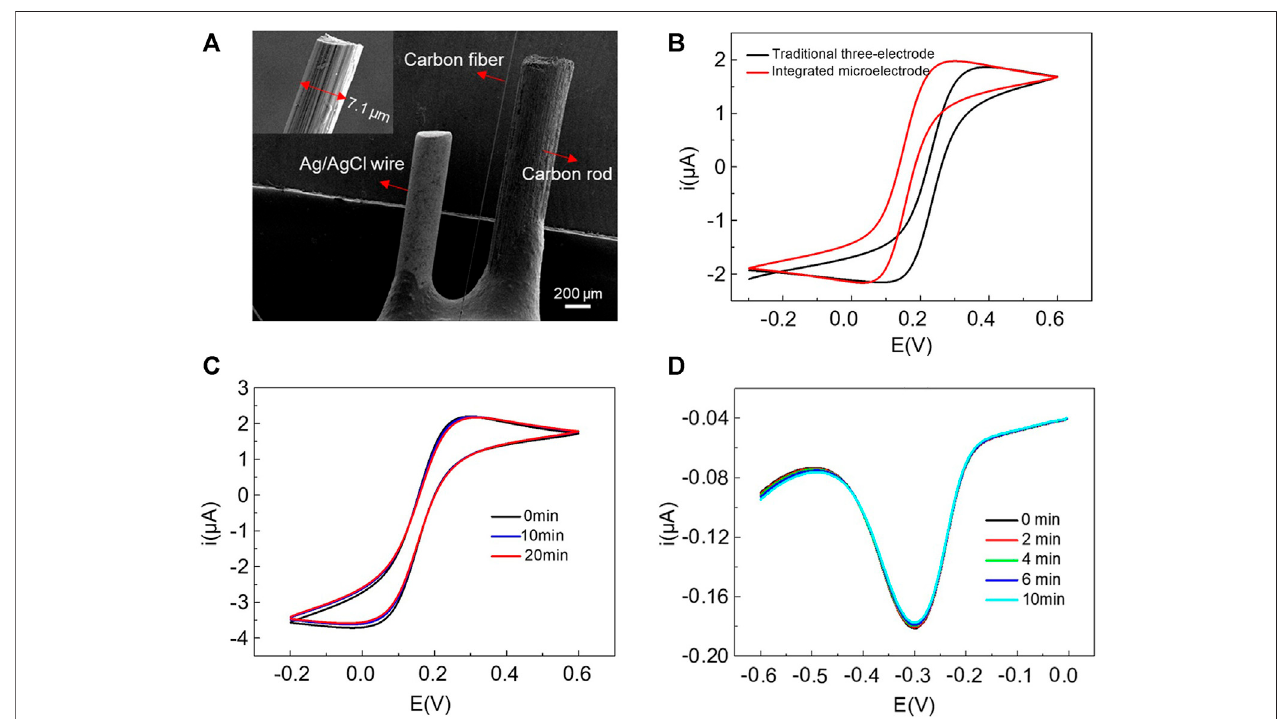
FIGURE 1 | (A) SEM images of the home-made integrated microelectrode and the carbon fi ber part with a diameter of 7 μ m (inset). (B) The comparison of CV curves measured with integrated microelectrode and traditional three-electrode system in 5 mM K 3 Fe (CN) 6 /K 4 Fe (CN) 6 solution. Continuous scanning of CV and